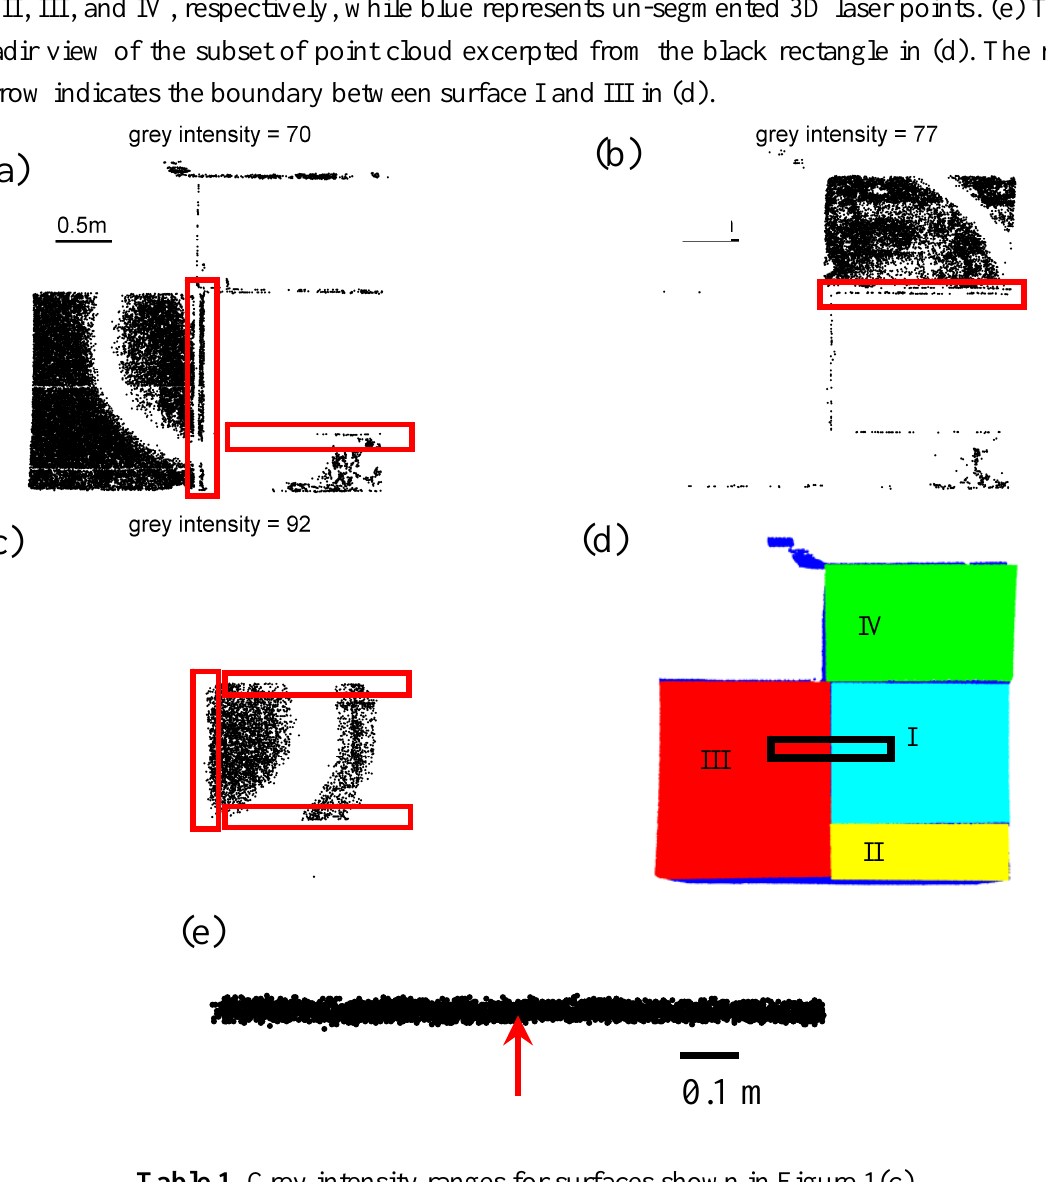
Table 1. Grey intensity ranges for surfaces shown in Figure